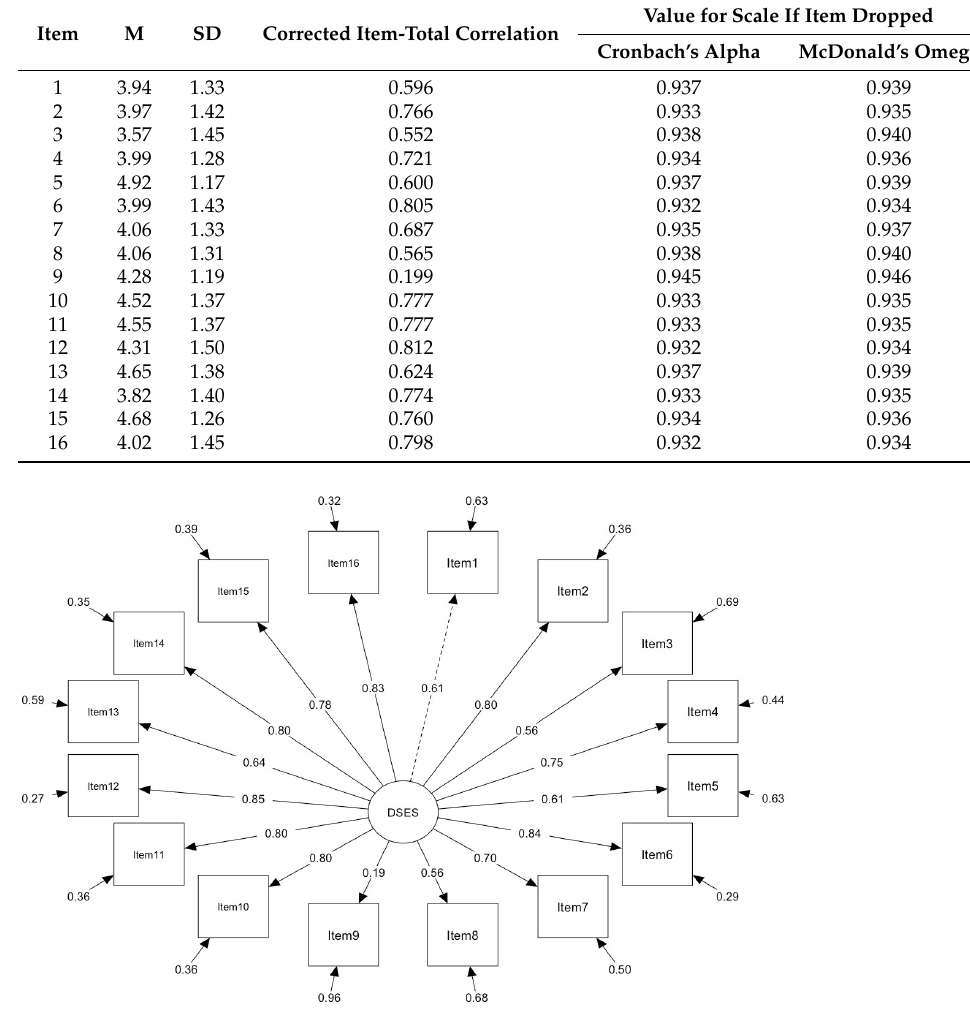
Figure 4. Diagram presenting the results obtained in confirmatory factor analysis for our data fitted to Underwood and Teresi’s (2002) unifactorial model in Sample